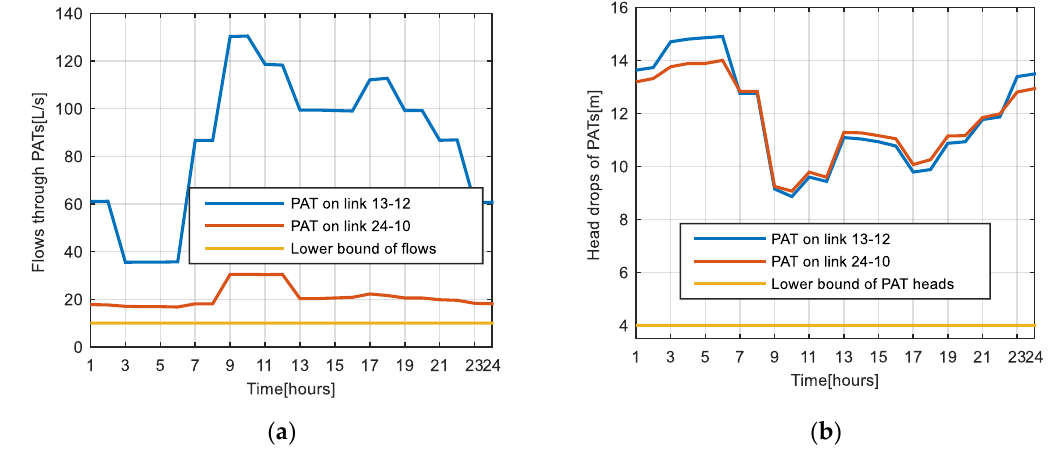
Figure 7. Flows through PATs ( a ) and head drops of PATs ( b ).